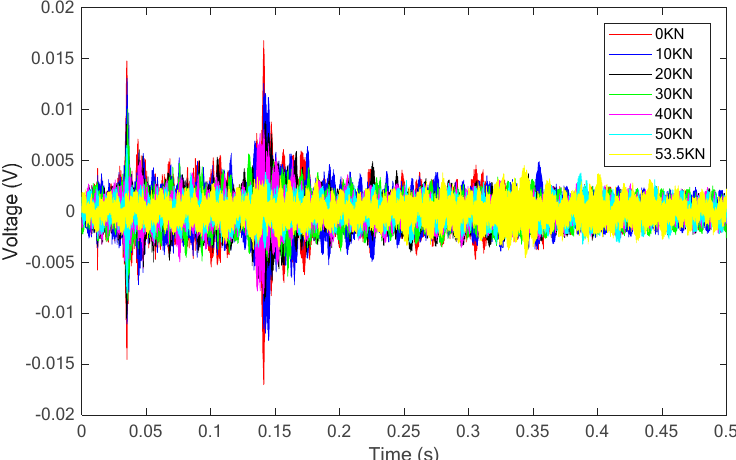
Figure 6. The curves of ( a ) time vs. load, ( b ) displacement vs. load.